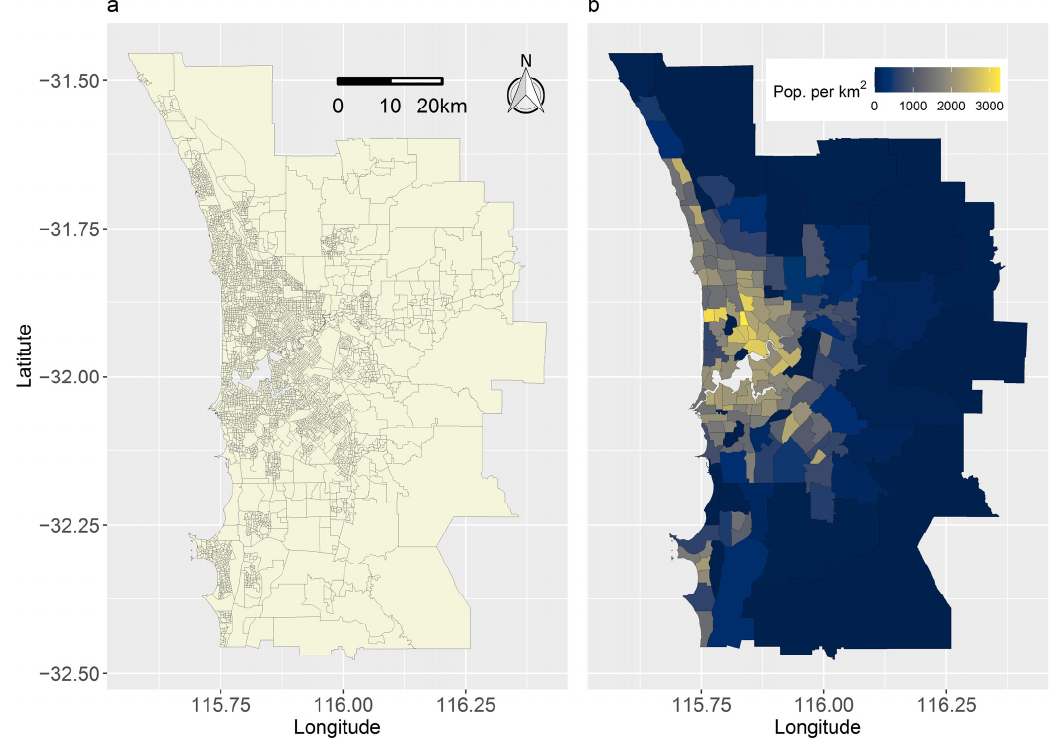
Figure 10. Administrative geography and population density of Perth in 2016. ( a ) SA1 and SA2 boundaries. ( b ) SA2-resolution population density. Figure 11a,b map the sets of TRs delineated for stroke using Marxan + MinPatch and the STA, respectively. As expected, given (1) the inverse distance-based weighting func- tion specified for the STA, and (2) that no simulated whittling was applied within Min- Patch, the TRs delineated using both methods were relatively compact (while conforming to the somewhat variable shapes of the SA1 boundaries). For Marxan + MinPatch, eight TRs were delineated in total; these contained 15.02% of strokes and 7.58% of the popula- tion; thus, their targeting efficiency can be expressed as 1.98% of strokes for every 1% of the population targeted (calculation: 15.02/7.58). By comparison, for the STA, 10 TRs were delineated in total; these contained 16.33% of strokes and 6.59% of the population; thus, their targeting efficiency can be expressed as 2.48% of strokes for every 1% of the popula- tion targeted (calculation: 16.33/6.59). These results are consistent with those of the simu- lation study: the targeting efficiency of the STA was greater than that of Marxan + Min- Patch, while the number of TRs was similar.